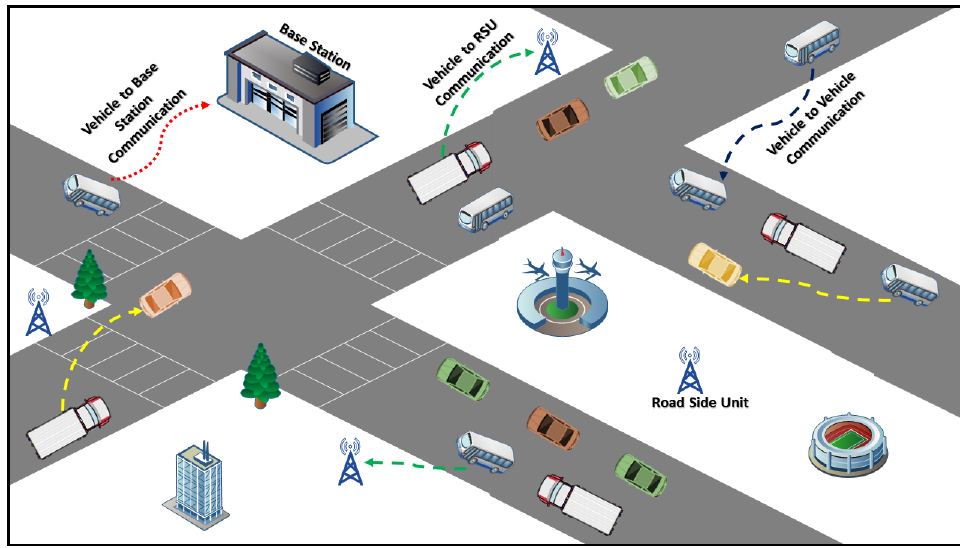
Figure 1. The VANET